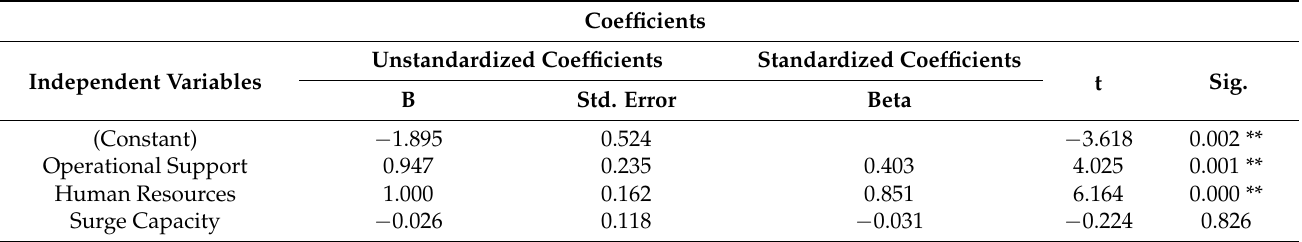
Table 8. Predictors of Continuity of Essential Services (dependent